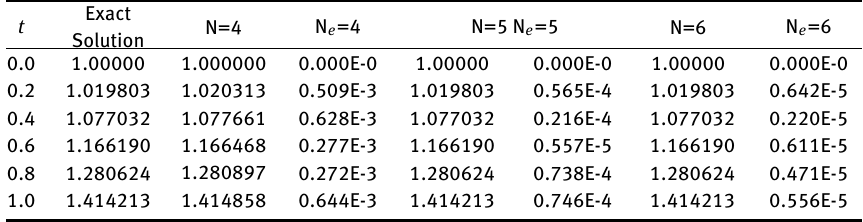
Table 4: Numerical result for approximate solution of y 1 ( t ) in Example 5.